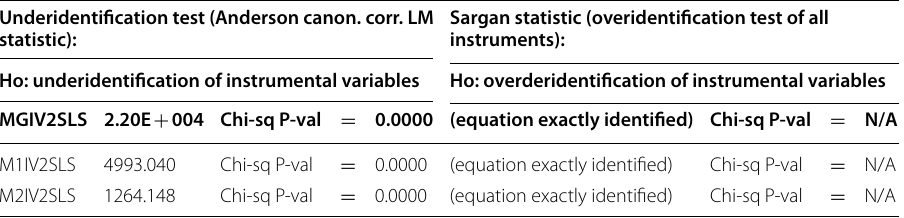
Table 6 Instrumental variables identification tests. Source : Own